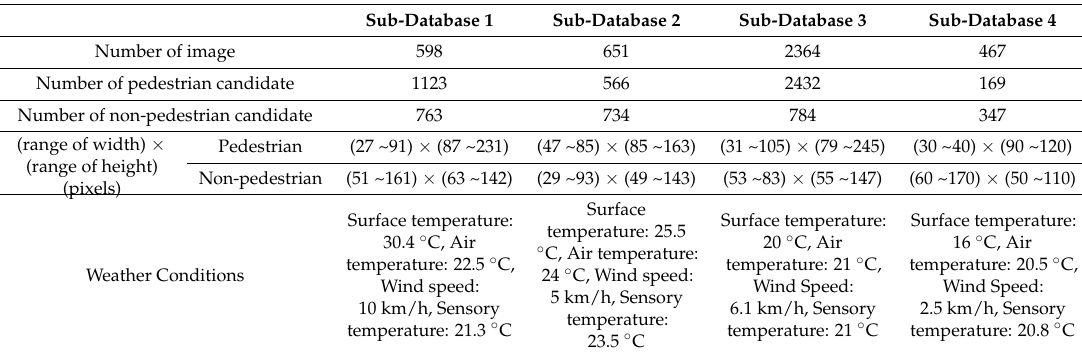
Table 6. Description of the database.